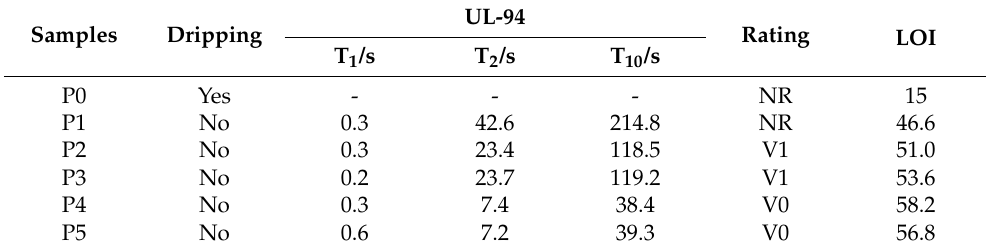
Table 3. UL-94 and LOI performance data of FR-POM